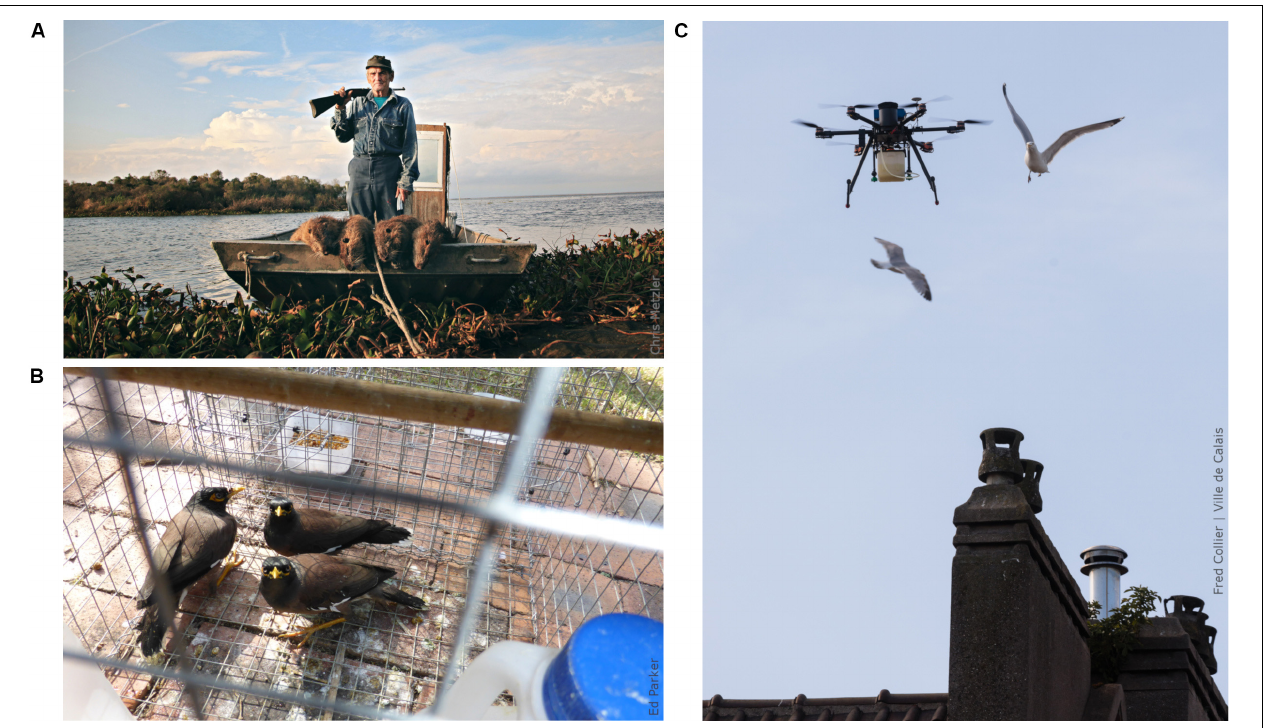
FIGURE 1 | Nuisance and invasive species are controlled by a range of methods and devices. (A) Nutria ( Myocastor coypus ) hunter in Louisiana, United States. Nutria have been introduced to North America, Europe and Asia from South America. Picture from “rodents of unusual size,” documentary by Quinn Costello, Chris Metzler and Jeff Springer. (B) Common mynas ( Acridotheres tristis ) in a walk-in baited trap in Queensland, Australia. Common mynas are invasive across the east coast of Australia, many local control programs rely exclusively on such traps. Picture by Ed Parker. (C) Drone intervention to sterilize seagull eggs in Calais, France. A number of French cities control urban seagull populations to reduce nuisance. Picture by Fred Collier | Ville de